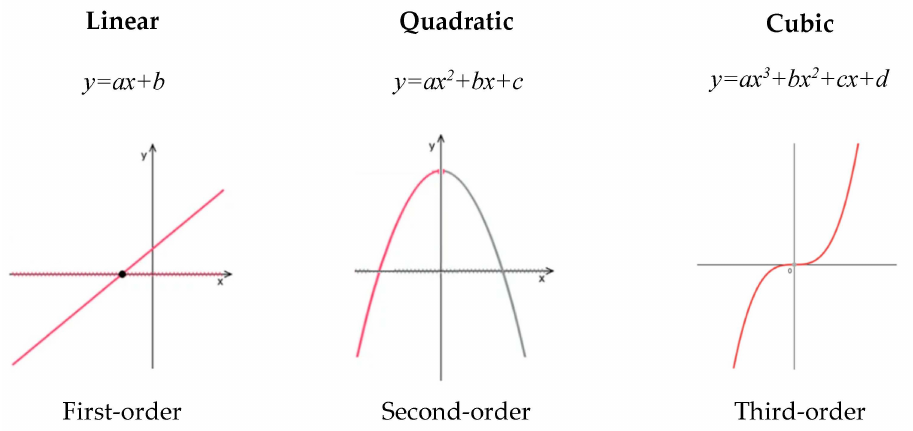
Figure 7. Polynomial shapes with their functions